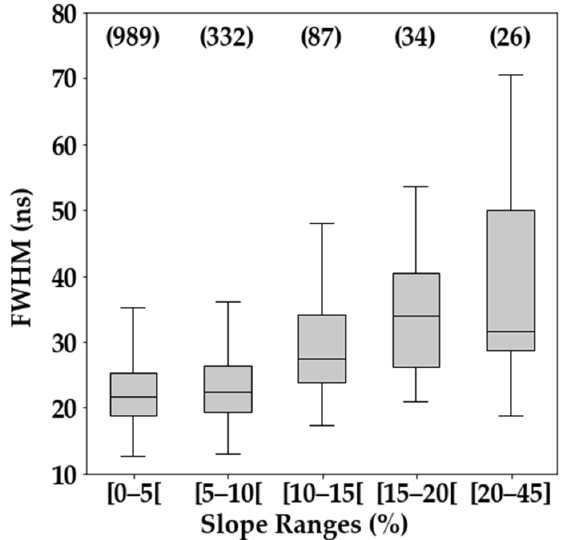
Figure 3. Box-whiskers plots of the full width at half maximum (FWHM) of the fitted ground return across five slope ranges. Numbers in parenthesis represent the number of points in each slope class.